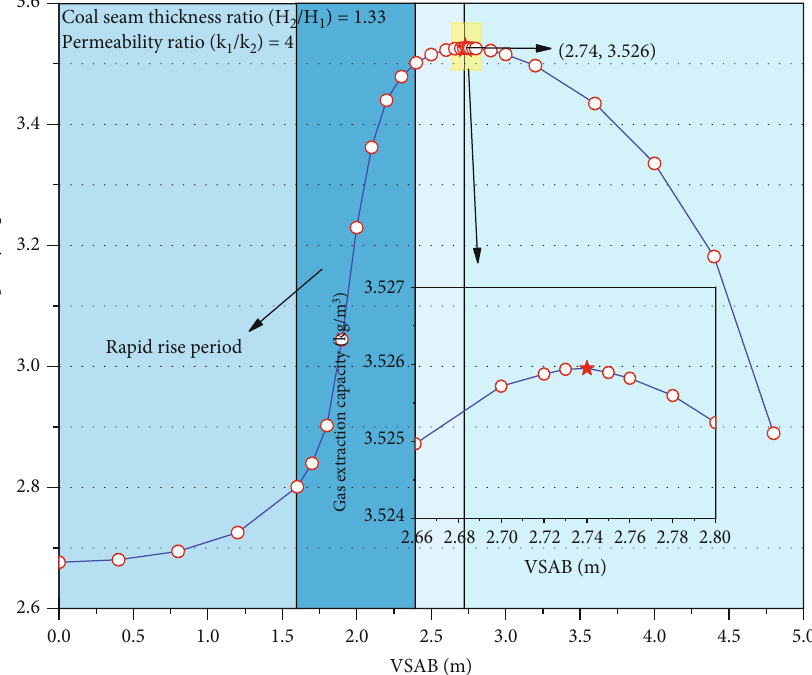
Figure 5: Gas extraction amount of typical combined coal seams